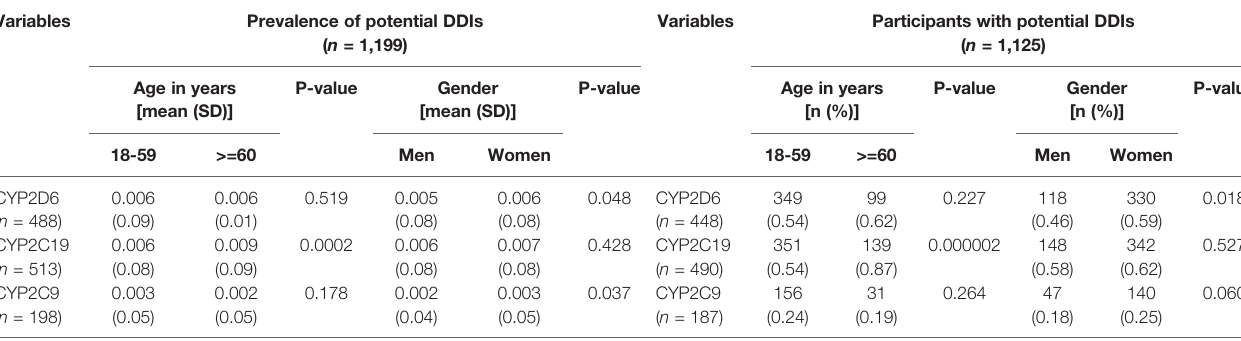
TABLE 2 | Prevalence and participants with potential DDIs in the Lifelines cohort.